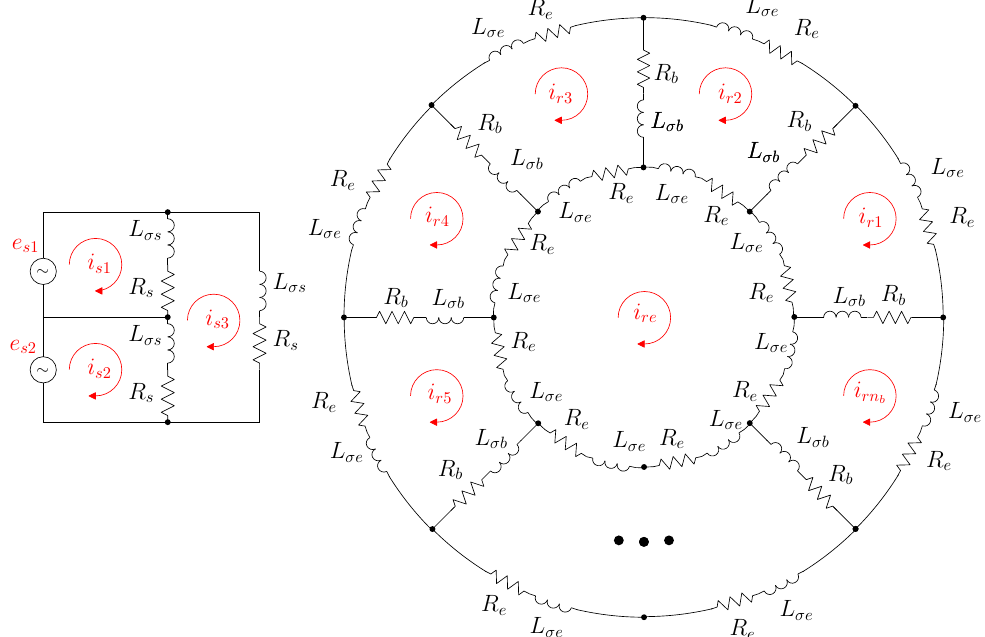
Figure 3. IM network. The three stator phases ( left ) have a delta connection, and each one has resistance R s and leakage inductance L σ s . The rotor cage ( right ) has n b bars. Each rotor loop consists in two consecutive bars, each one with resistance R b and leakage inductance L σ b . The bars are connected trough end ring segments, each one with resistance R e and leakage inductance L σ e . The self and mutual inductances of the windings are not represented in this